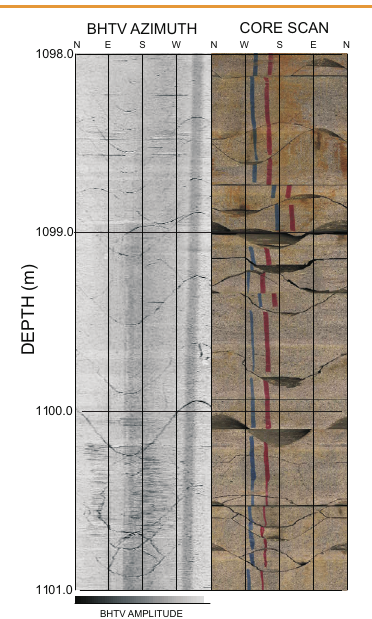
Figure 7. Examples of BHTV and core images from the Kimama 2A corehole. Comparison of ultrasonic borehole televiewer images through naturally fractured rhyolite with the corresponding unwrapped core scans. The core scans have been oriented based on the televiewer images. Note that the core image mirrors that of the